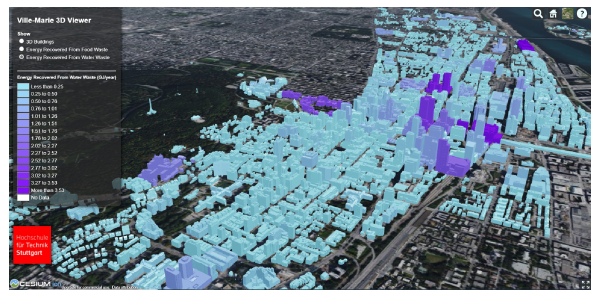
Figure 19. Energy recovered from water waste in